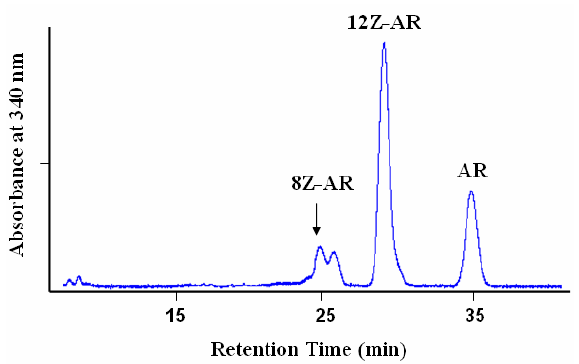
Figure 5: Reversed-phase HPLC profile and UV-visible absorption spectra of RP photodecomposition products identified as all- trans -AR (AR) and cis -ARs (6Z-, 8Z-, and 12Z-AR). HPLC analysis was conducted on a Vydac C column (4.6 x 250 mm) eluted isocratically with water in methanol (14/86; v/v) at 1 mL/min.